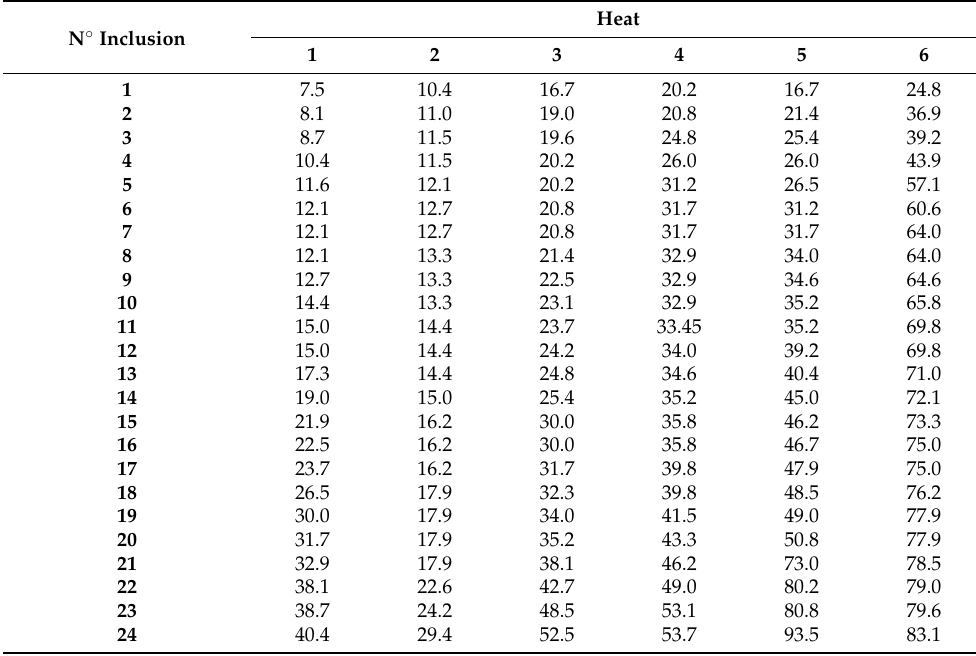
Table 2. Inclusion maximum length L max ( μ m) for analyzed plans in each heat.